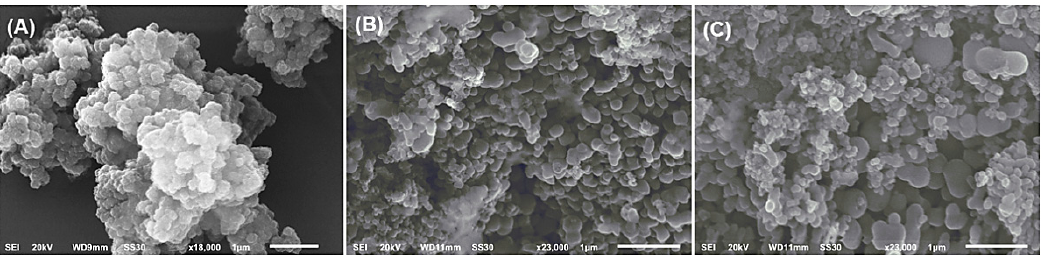
Figure 2. SEM images of different NFs: ( A ) PBA-CSNPs (NF-1), ( B ) PBA-CSNPs-VOO (NF-2), ( C ) PBA-CSNPs-HT (NF-3).